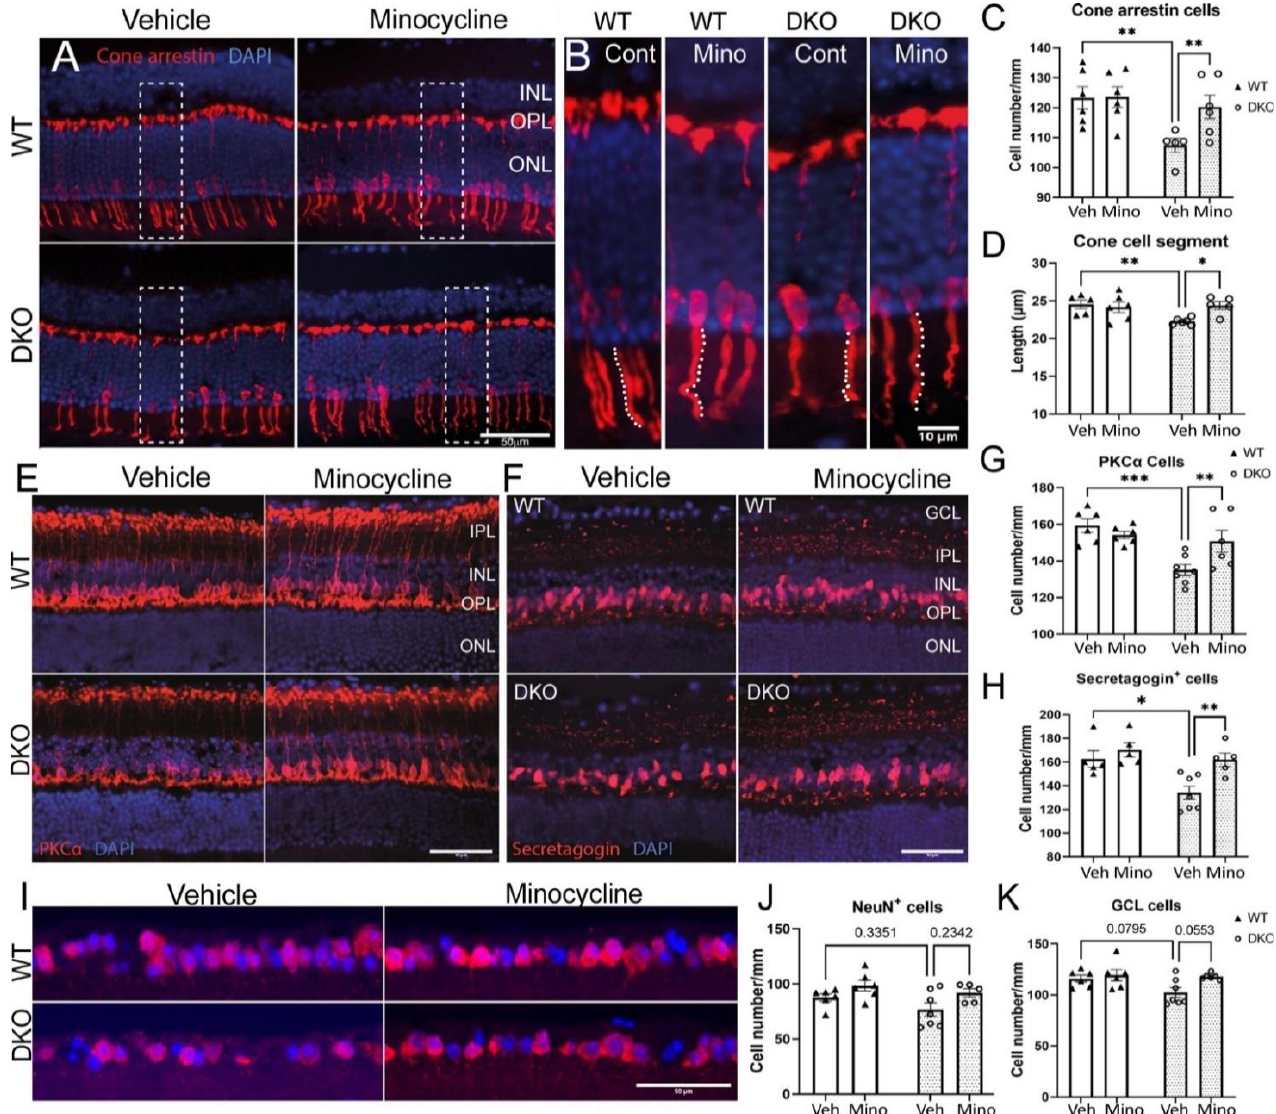
Figure 7. The effect of minocycline on retinal neuronal degeneration. ( A ) Representative images showing cone arrestin + cells from different groups. Cell nuclei were stained with DAPI. High magnification of the rectangle areas is shown in ( B ). White dotted lines in ( B ) illustrate the measurement of inner/outer segment of cone arrestin + cells. ( C ) The number of arrestin + cells in different groups. ( D ) The cone segment length in different groups. ( E , F ) Representative images of PKCα + ( E ) and secretagogin + ( F ) cells from different groups. ( G , H ) The number of cone arrestin + ( G ) and secretagogin + ( H ) cells in different groups. ( I ) Representative images of NeuN + cells from different groups. Nuclei were stained with DAPI. ( J ) The number of NeuN + cells in different groups. ( K ) The number of DAPI + cells in the ganglion cell layer (GCL) in different groups. Scale bars = 50 µm in ( A , E , F , I ). Mean ± SEM, n = 6, * p <0.05, ** p < 0.01; *** p < 0.001 by 2-way ANOVA with Sidak’s multiple comparison test. GCL: ganglion cell layer, IPL: inner plexiform layer; INL: inner nuclear layer; OPL: outer plexiform layer; ONL: outer nuclear layer. Veh: vehicle; Mino: minocycline. The rod bipolar cells were identified by PKC α (Figure 7E) and cone secretagogin was used to identify cone bipolar cells (Figure 7F). The number of PKC α + (Figure 7G) and secretagogin + (Figure 7H) bipolar cells did not differ between vehicle- and minocycline- treated WT mice. Vehicle-treated DKO mice had a significantly lower number of PKC α